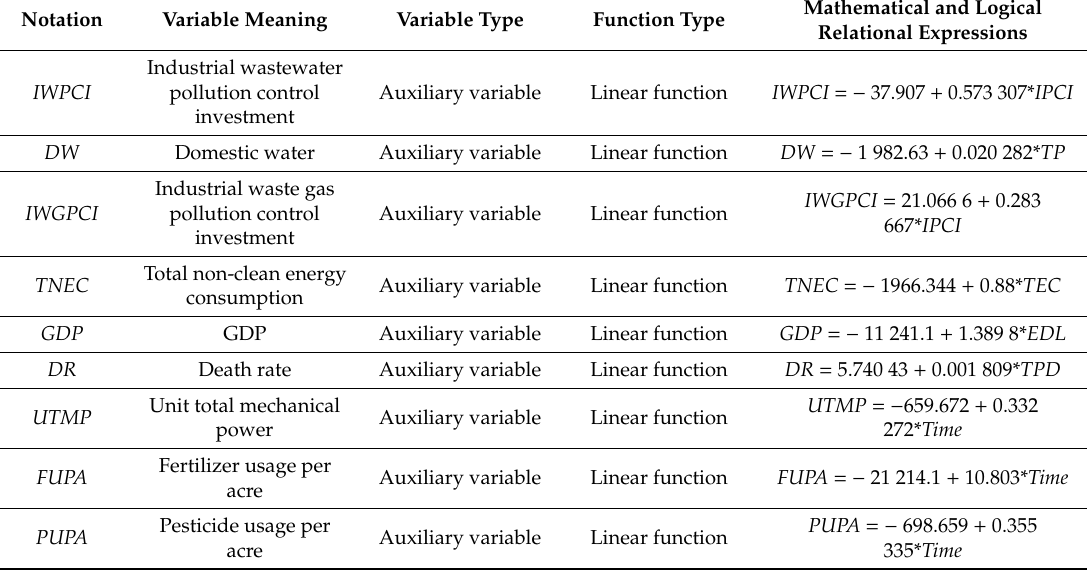
Table A1. Main variables and parameters index of China’s water-food-energy